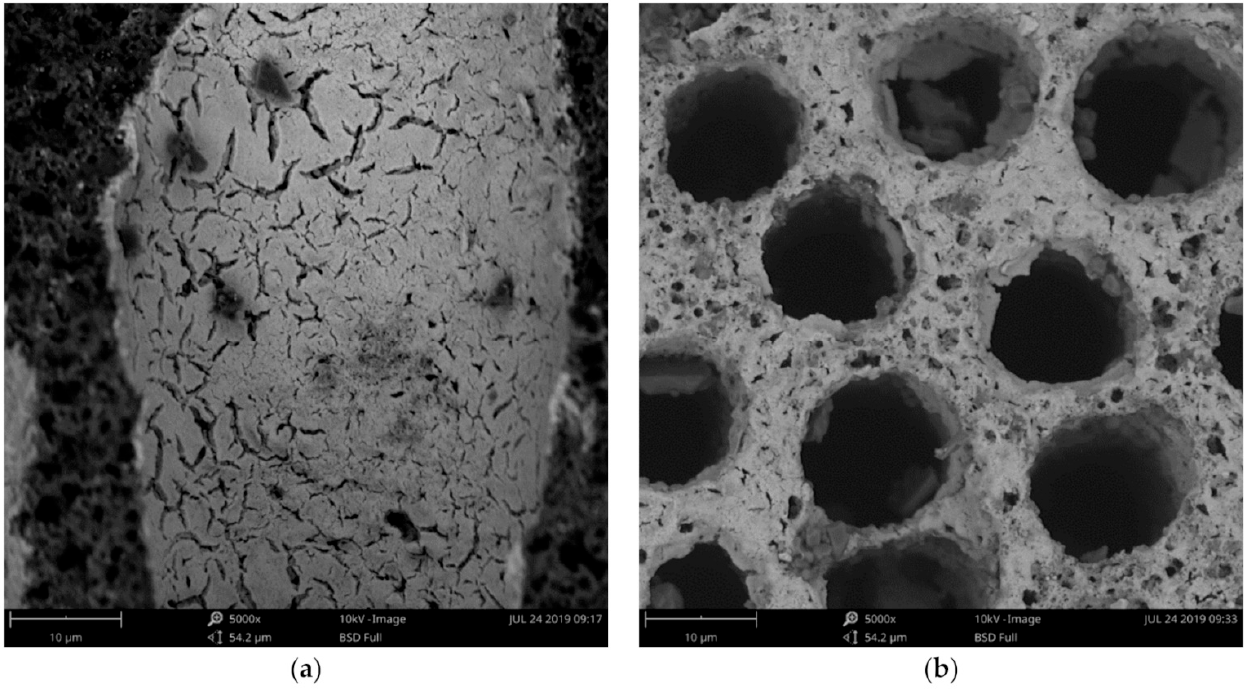
Figure 2. ( a ) Cross-section and ( b ) top view SEM image of Ni-CGO microchannel reactor